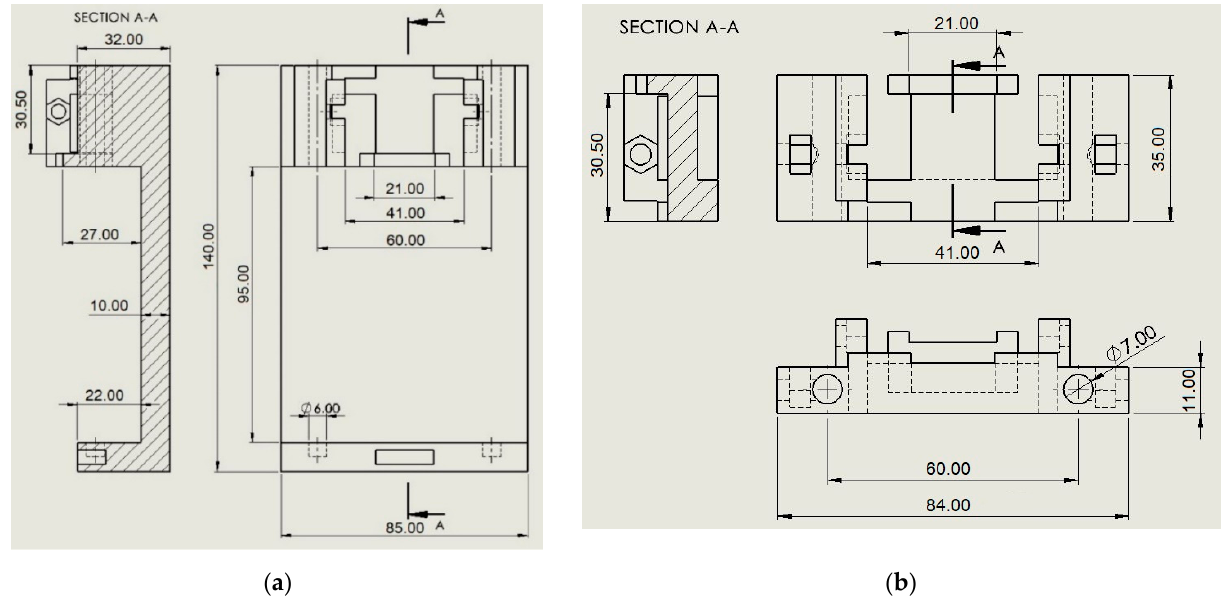
Figure 7. Dimensions of main parts: ( a ) U-shape profile with integrated groove; ( b ) the slider with groove.